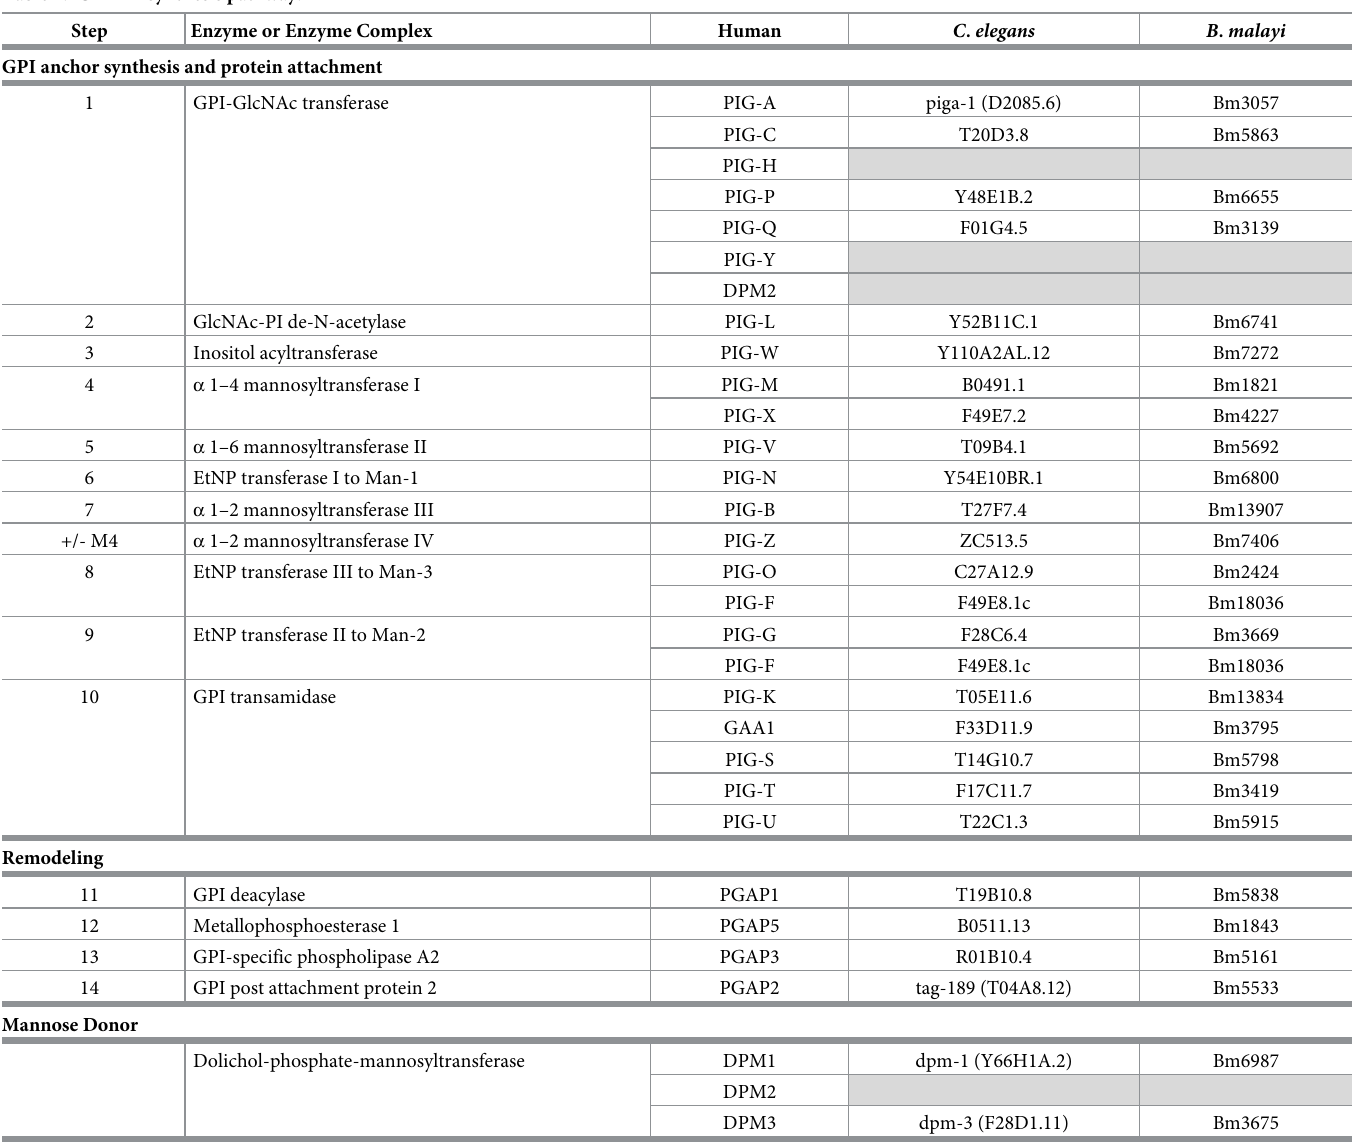
Table 1. GPI-AP synthesis